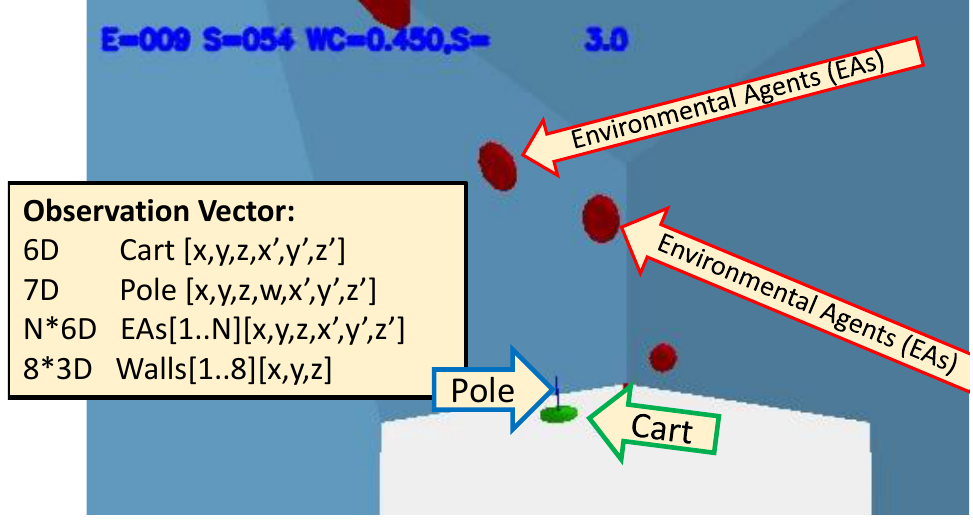
Figure 1. Our multi-type novelty experimental environment uses CartPole3D, where the goal is to keep the pole balanced. The environment has a controllable cart (green) balancing a pole (blue). It also has added independently moving environmental agents (red). The environment can be changed to provide for multiple subtypes of novelty. The Open World Control Agent (WOW-agent) only sees the observational vector of 37-73 numeric values of the position/velocity of the cart, pole, the environmental agents, and the walls that define the world boundaries. In each episode, it receives the observations of each step, makes a control decision (left, right, front, back, none), and tries to keep the pole balanced for 200 timesteps. It reports the probability the world is novel in each episode. The image also shows episode (E=) and step number (S=), the WOW-agent’s probability that the world has changed (WC=) to a novel state and the WOW-agent score